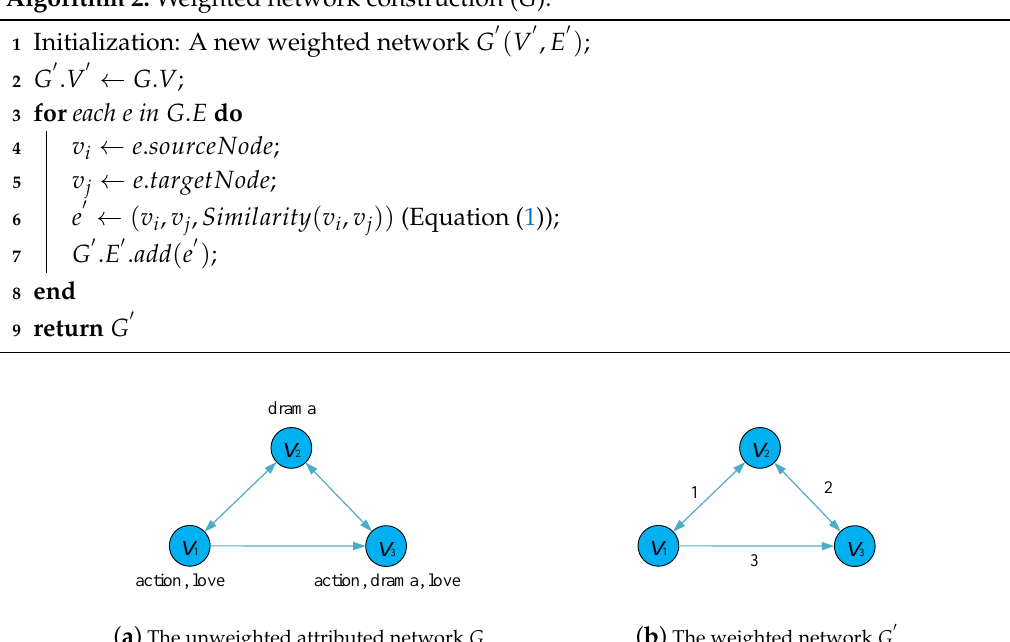
Algorithm 2: Weighted network construction ( G ).